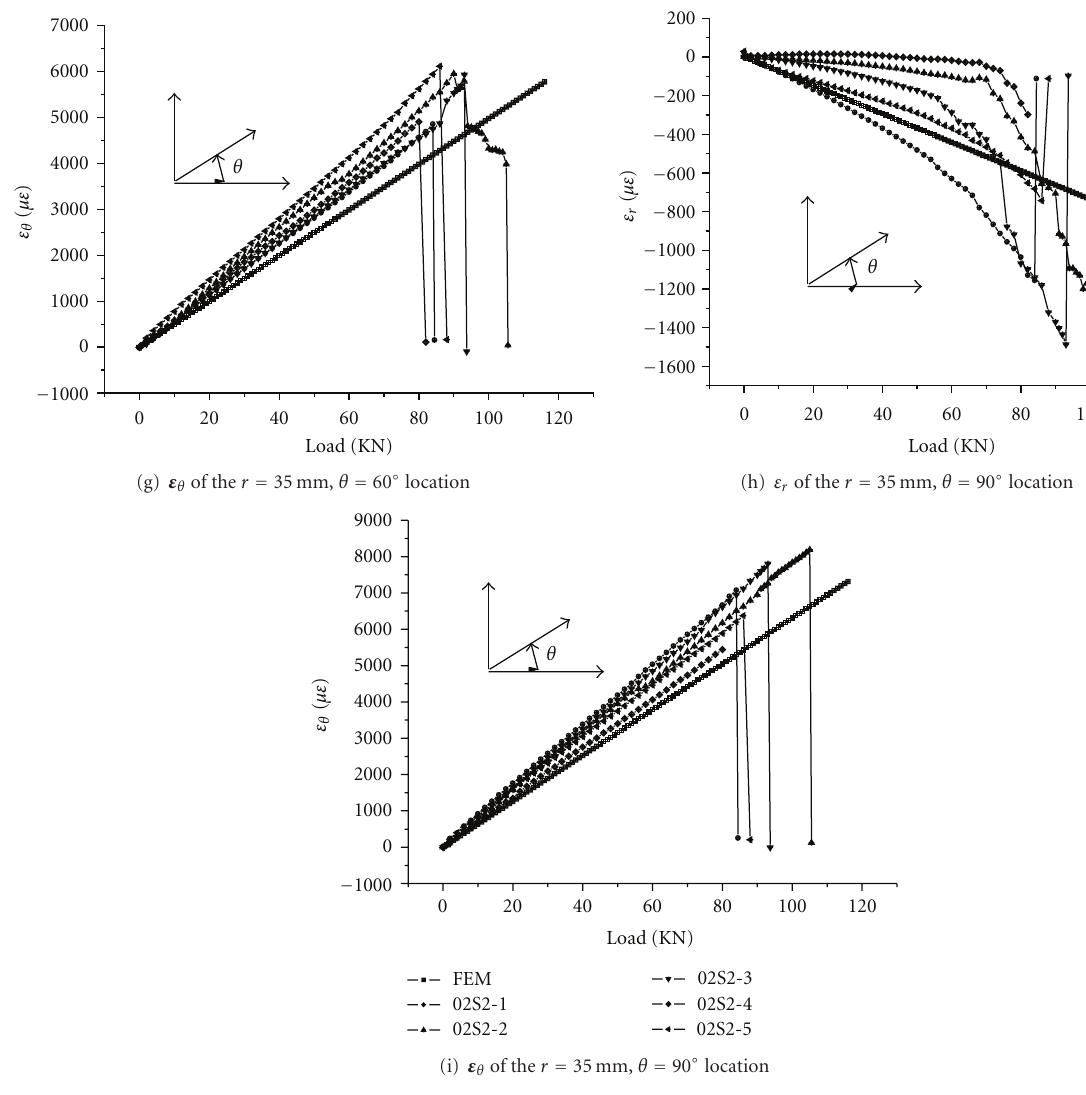
Figure 14: Strain of single-line